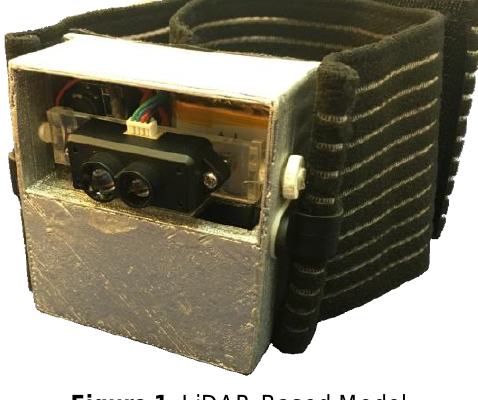
Figure 1. LiDAR Based Model.